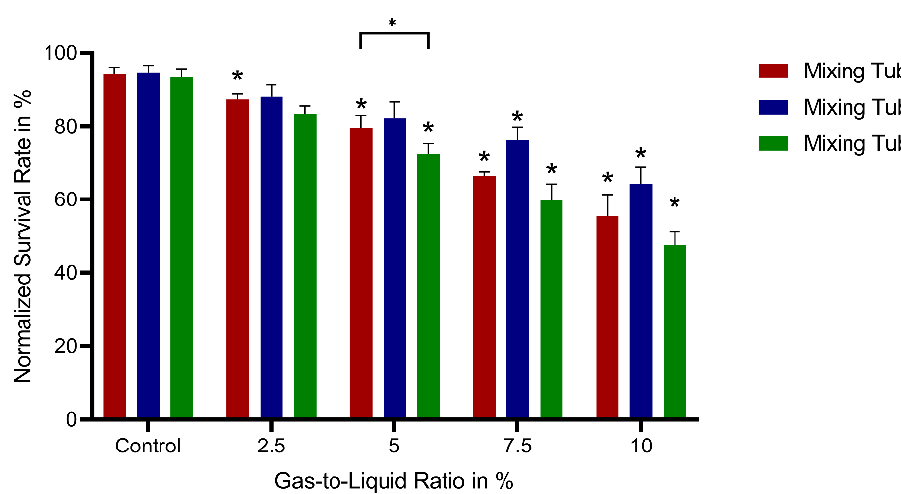
Figure 6. Normalized survival rates of sprayed ASCs ( n = 3) for different mixing tubes (A, B, C) and gas-to-liquid ratios. Significant differences with p < 0.05 were considered as significant and are marked with *. Asterisks above a bar refer to significant differences compared to the respective control. Values were compared for each gas-to-liquid ratio.